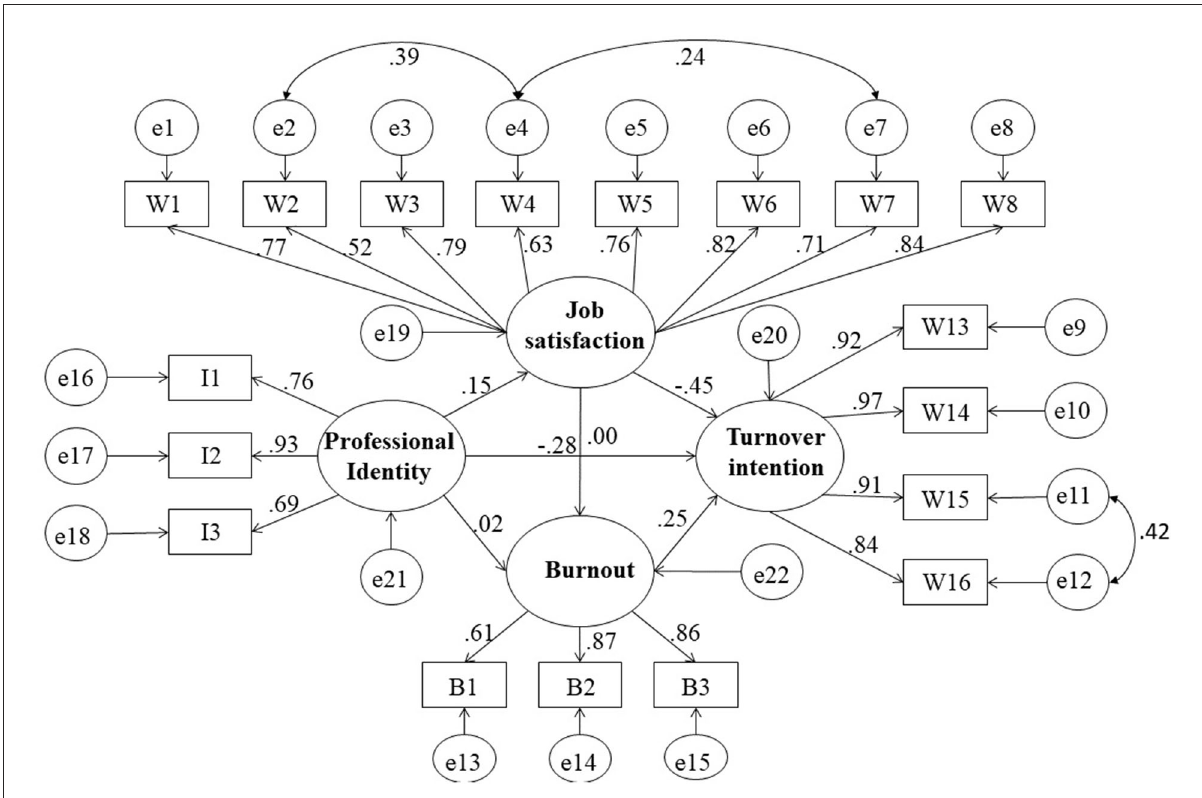
FIGURE2 The final model and standardized model